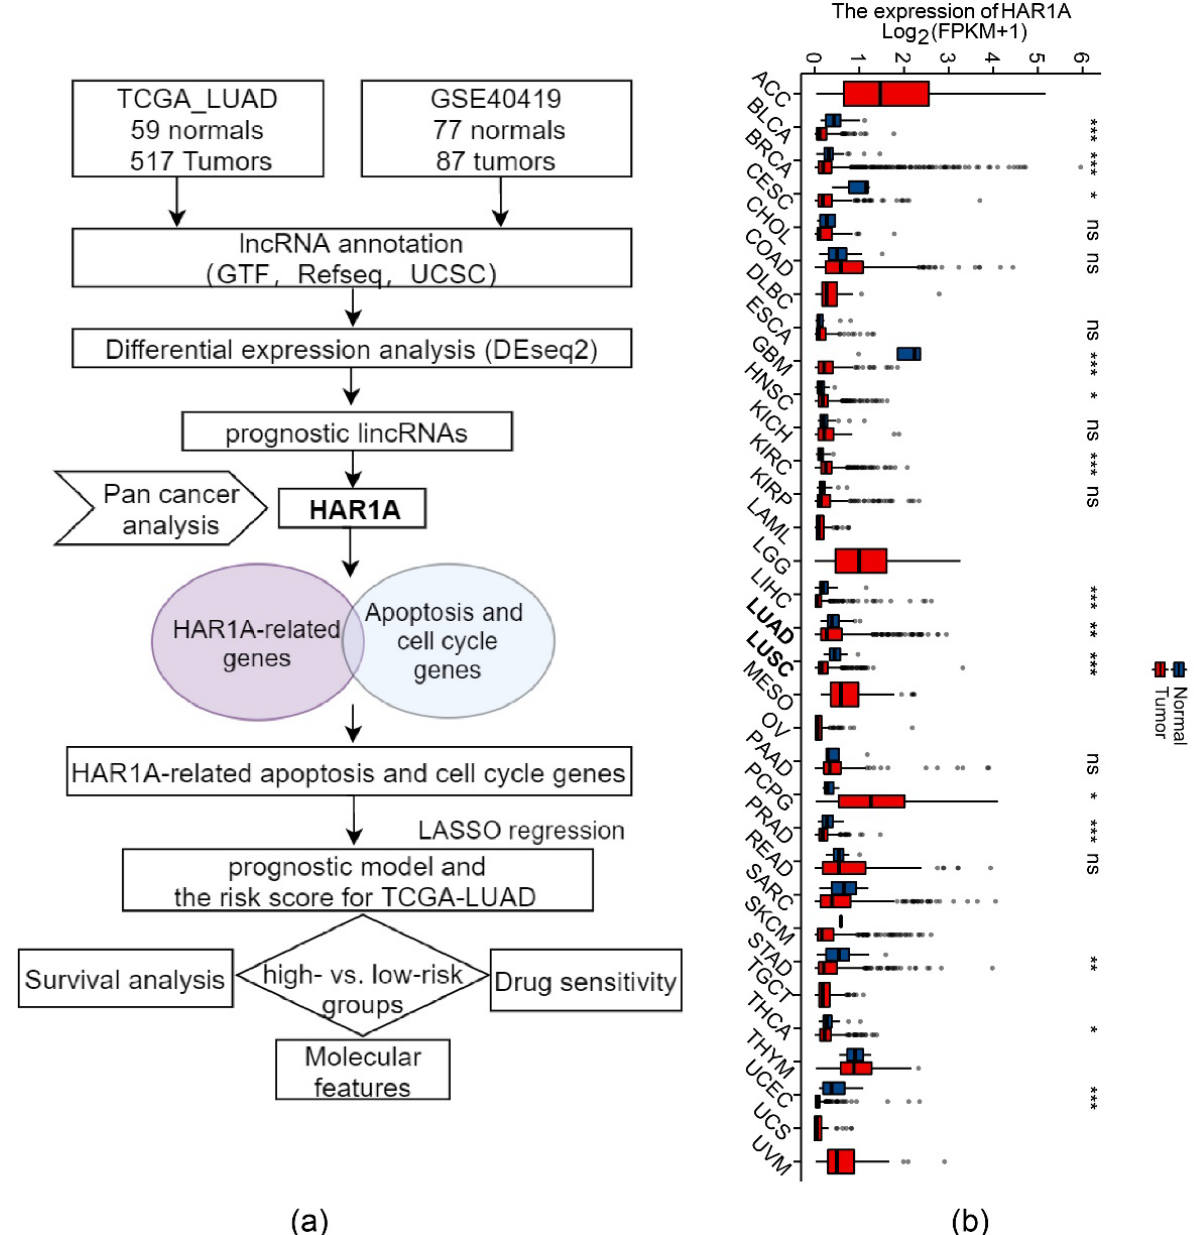
Figure 1. Decreased lncRNA HAR1A in tumors. ( a ) The workflow for selecting differentially expressed lncRNAs between LUAD and normal tissues. ( b ) lncRNA HAR1A was downregulated in various types of cancer. *, p < 0.05, **, p < 0.01, ***, p < 0.001, ns, not significant.